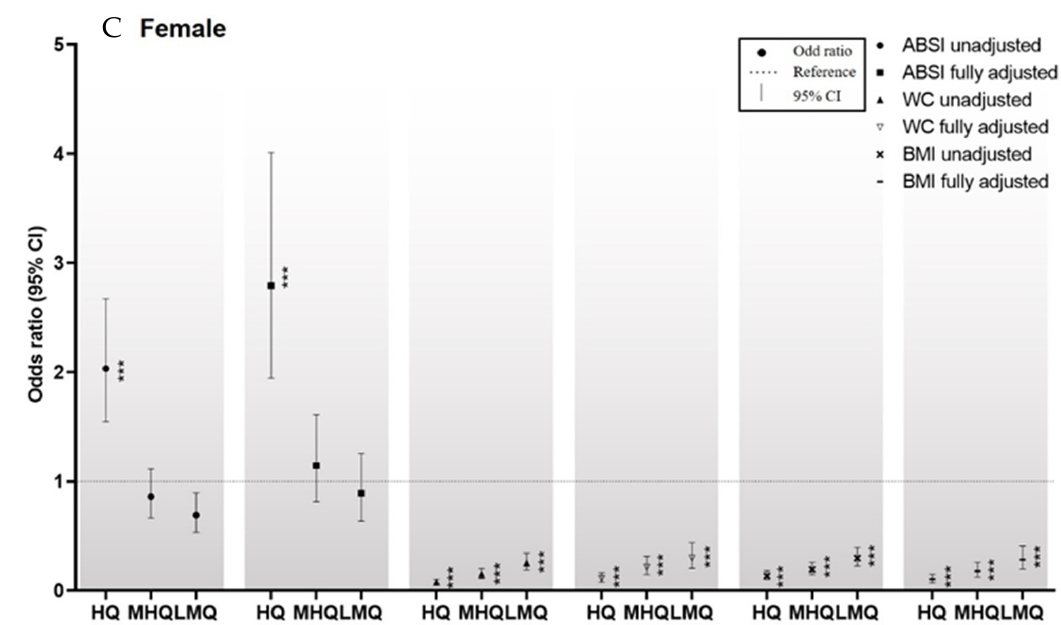
Figure 4. ( A – C ) Comparisons of the ORs for men, women, and the entire group for the relationships of the Z-scores of ABSI, WC, and BMI with osteoporosis. * p < 0.05, ** p < 0.01, and *** p < 0.001 for the ORs for osteoporosis, compared with the lowest quartile. Abbreviations: HQ, highest quartile; MHQ, middle-high quartile; LMQ, low-middle quartile. The ORs for the entire group for the relationships between the Z-scores for WC, BMI, and ABSI and osteoporosis are shown in Figure 4A. Depending on their Z-scores for WC, BMI, and ABSI, the participants were placed into quartiles. In the case of the Z-score for ABSI, in the unadjusted model, and compared to the lowest quartile, the highest quartile had an OR of 1.954 (95% CI: 1.613–2.367) for osteoporosis. In the fully adjusted model, and compared to the lowest quartile, the highest and middle-high quartiles had ORs of 2.202 (1.771–2.737) and 1.282 (1.036–1.585), respectively. As regards to the Z-score for WC, in the unadjusted model, and compared to the lowest quartile, the low-middle, middle-high, and highest quartiles showed ORs of 0.410 (0.335–0.503), 0.258 (0.211–0.317) and 0.142 (0.115–0.175), respectively for osteoporosis. In the fully adjusted model, and compared to the lowest quartile, the low-middle, middle-high, and highest quartiles had ORs of 0.461 (0.368–0.577), 0.313 (0.249–0.393), and 0.166 (0.131–0.210), respectively, for osteoporosis. With respect to the Z-score for BMI, in the unadjusted model, and compared to the lowest quartile, the low-middle, middle-high, and highest quartiles had ORs of 0.344 (0.280–0.421), 0.240 (0.195–0.294), and 0.166 (0.135–0.205), respectively, for osteoporosis. In the fully adjusted model, and compared to the lowest quartile, the low-middle, middle-high, and highest quartiles had ORs of 0.302 (0.240–0.380), 0.203 (0.160–0.256), and 0.120 (0.095–0.153), respectively, for